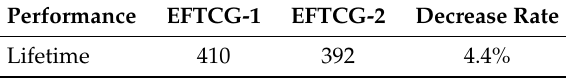
Table 3. The average reduction of energy